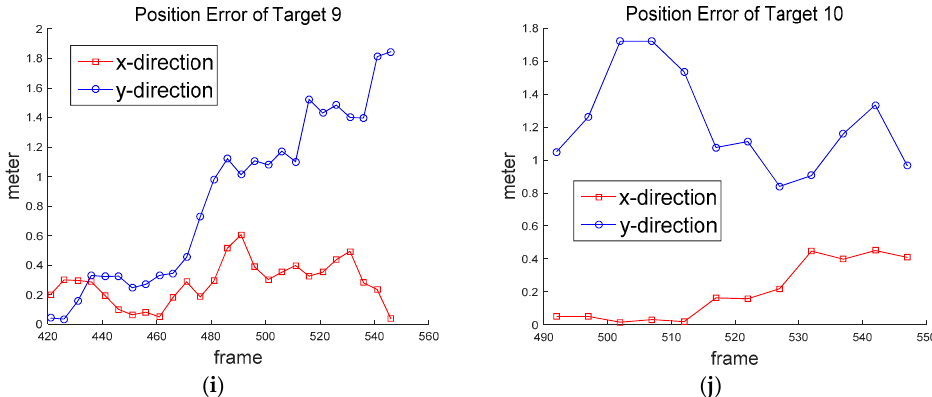
Figure 14. Position error of ( a ) Target 1, ( b ) Target 2, ( c ) Target 3, ( d ) Target 4, ( e ) Target 5, ( f ) Target 6,